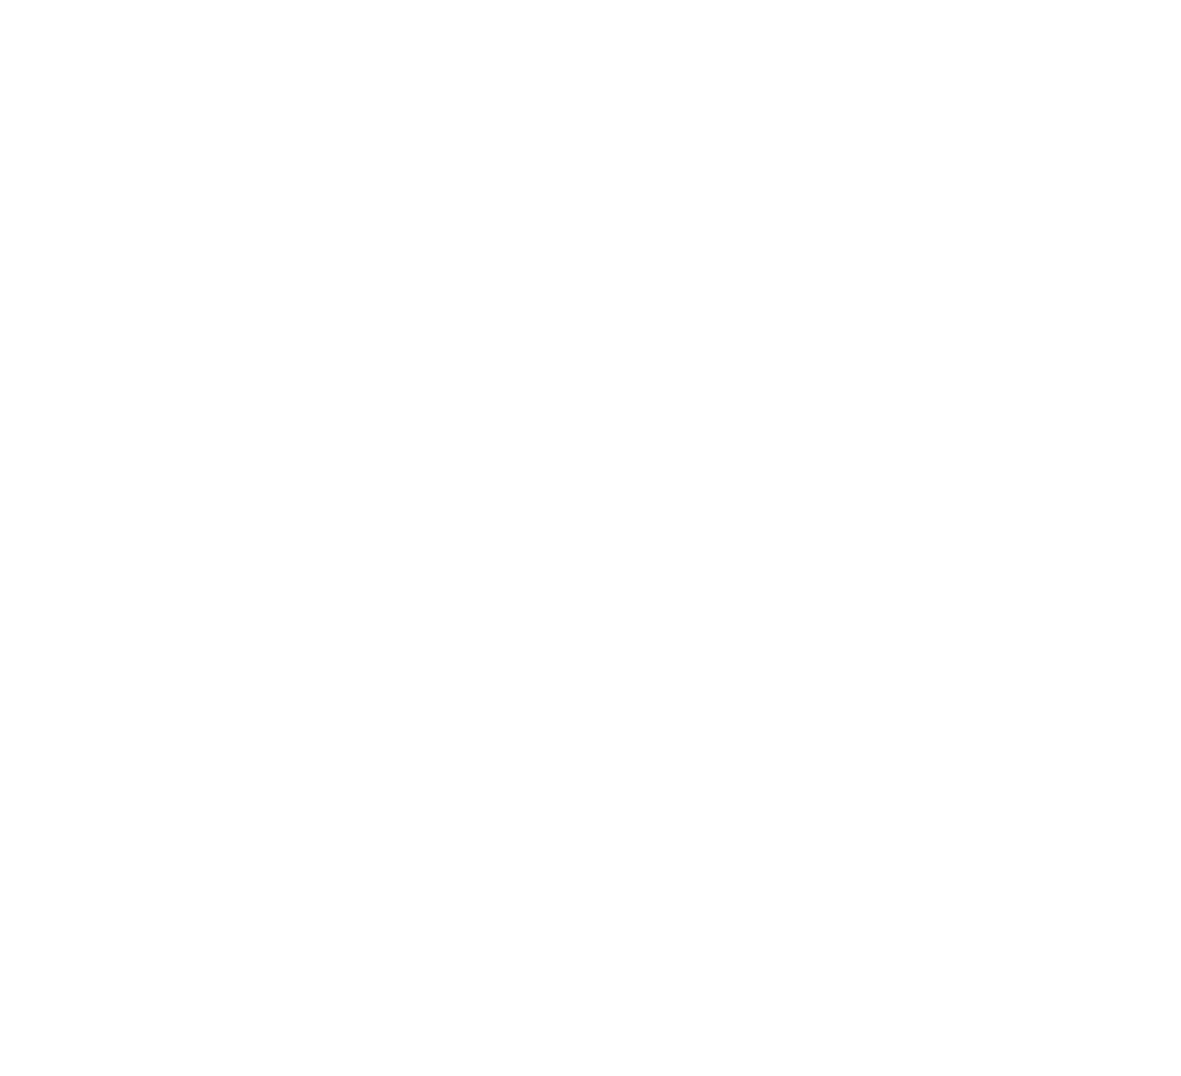
FIGUREA3 | Infiltration ofT cells in the CNS of MOG 35–55 -immunized mice .The dot plots and bar graph show the comparison of the percentages and total number of CD3 + T cells infiltrated in the spinal cord of control or